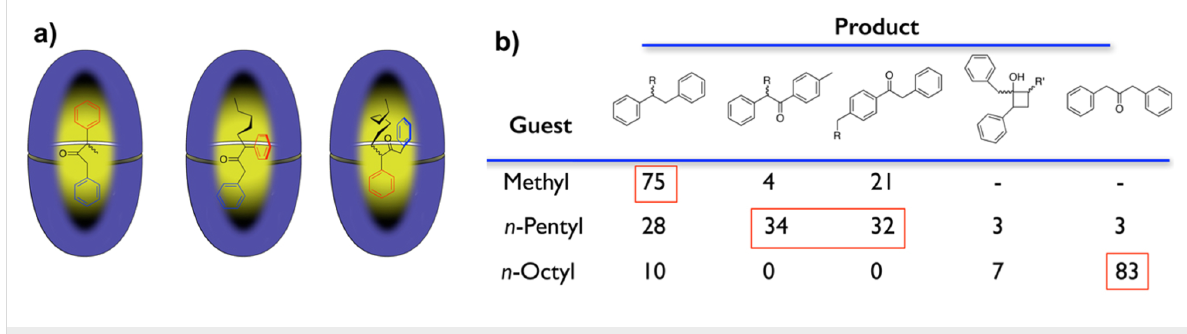
ward. The chosen esters (Figure 11) are so similar that it is difficult to separate them chromatographically, and in basic solution they cannot be kinetically resolved because they undergo hydrolysis to the corresponding inseparable acids at approximately the same rate. How would the capsule formed by octa-acid affect this situation? To keep things manageable we focused on pairs of esters. In the presence of octa-acid one of the esters preferentially binds to the capsule and is kept “safe” in the confines of the container, whilst the weaker binding competitor is primarily left in solution and undergoes hydroly- sis. Ideally therefore, none of the stored ester undergoes hydro- lysis, before all of the second reacts. We discovered that the esters all formed kinetically stable 2:1 host–guest complexes and bound with the following relative affinity to the